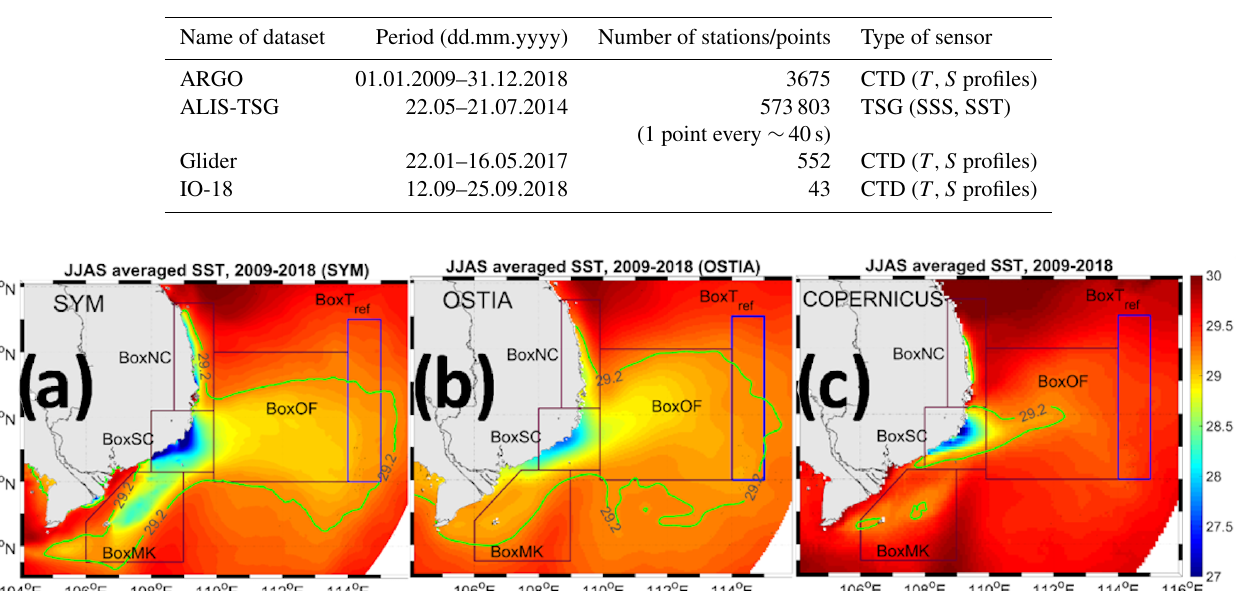
Table 1. Information about in situ measurements used in this study.